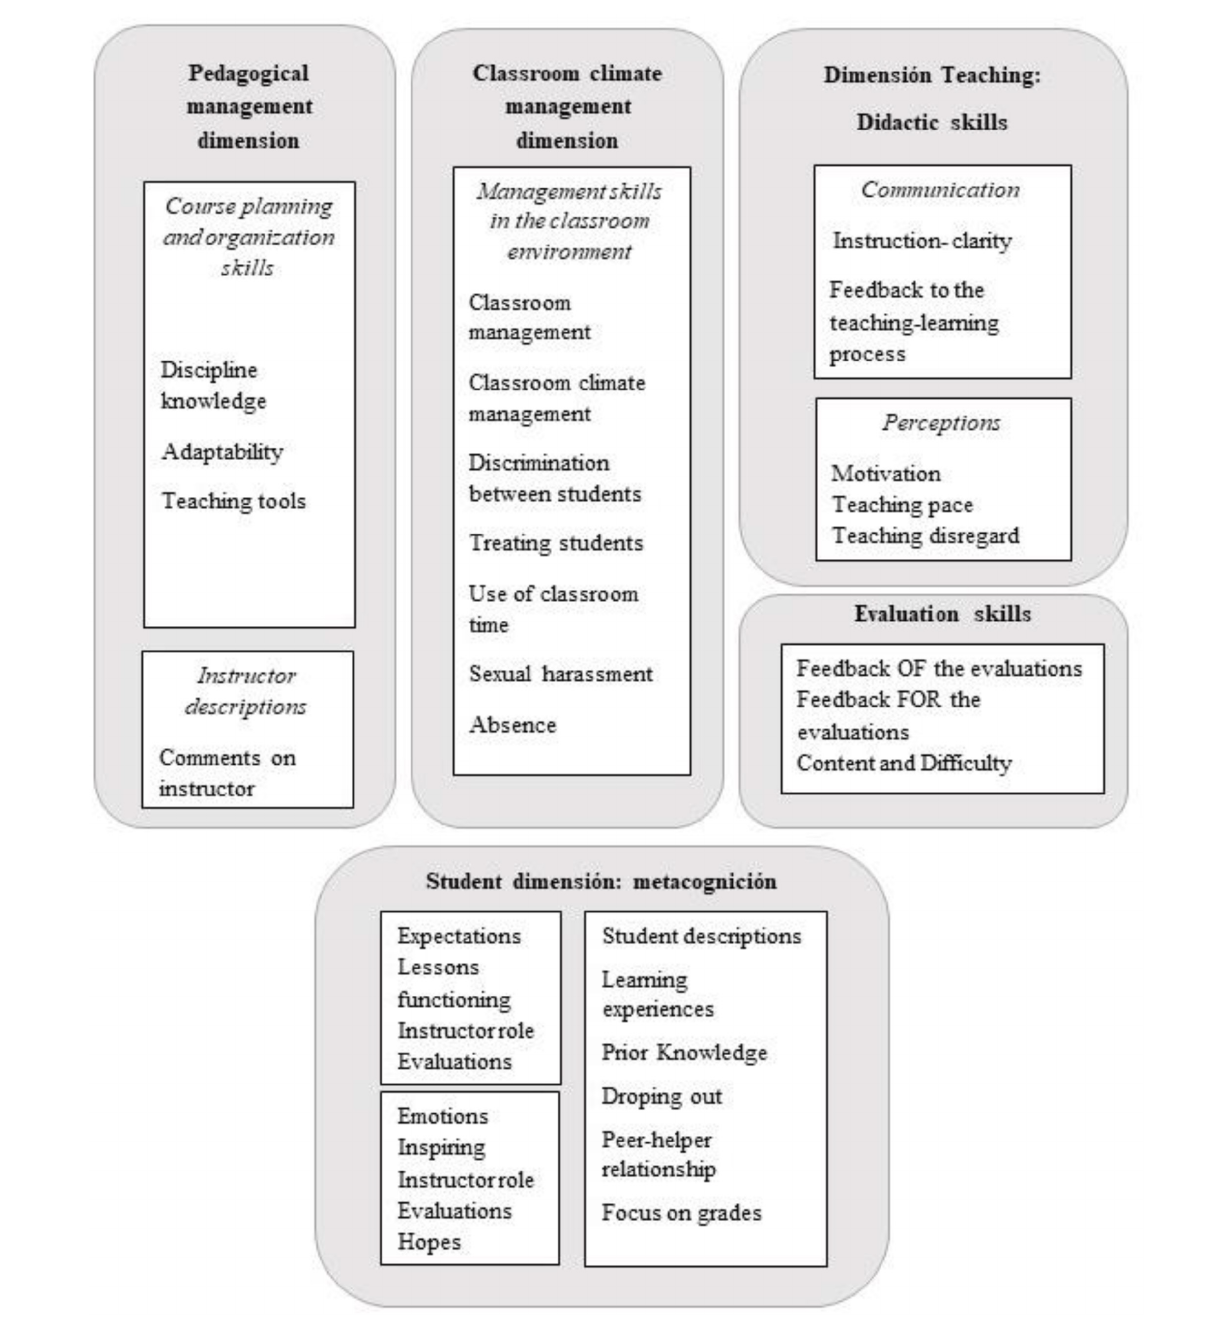
FIGURE 1 | Analytical